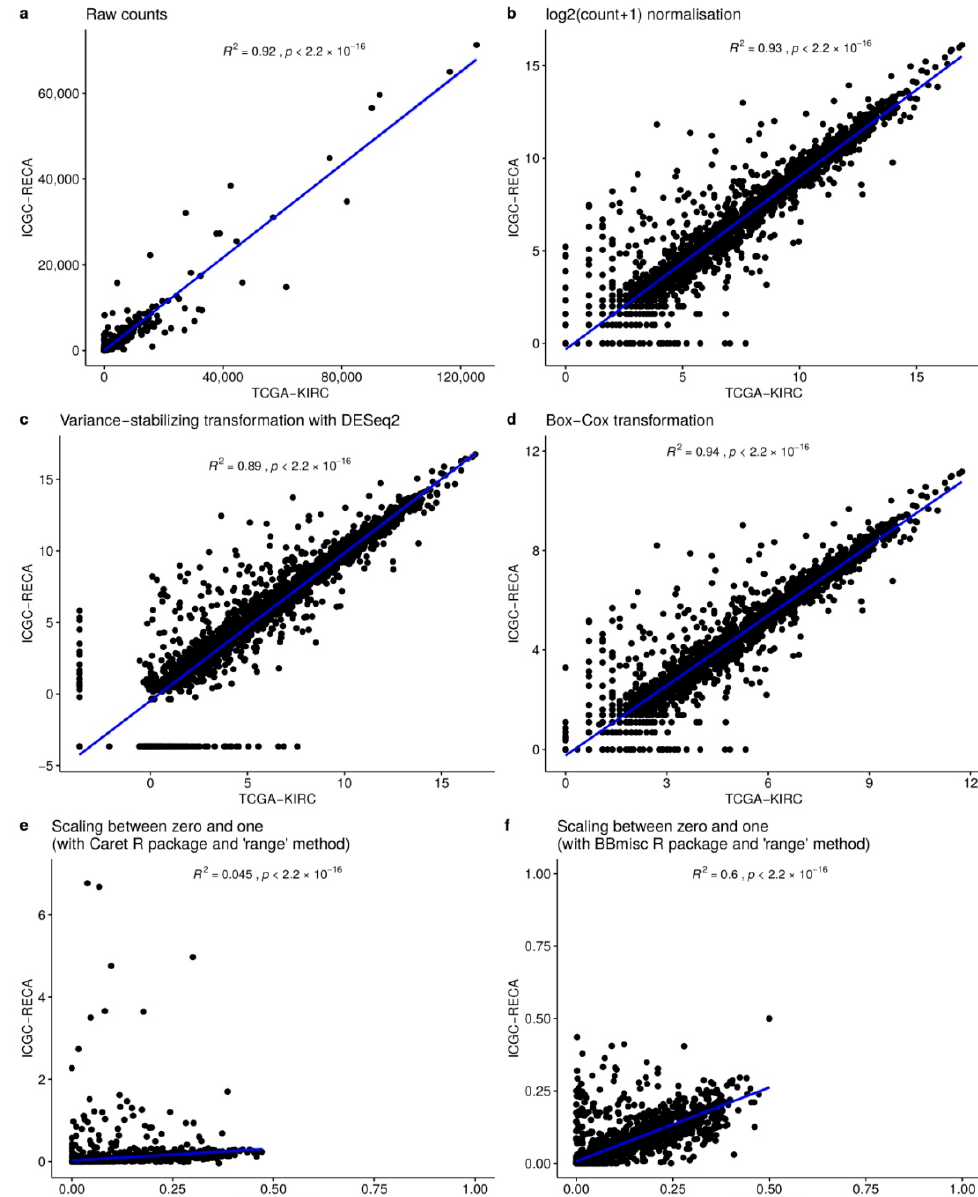
Figure A2. Scatter plot of median of gene expression comparing TCGA-KIRC and ICGC-RECA gene expression. ( a ) Raw counts. ( b ) log2(count + 1) normalization. ( c ) Variance-stabilizing transformation with DESeq2. ( d ) Box-Cox transformation. ( e ) Scaling between zero and one (with Caret R package and ‘range’ method). ( f ) Scaling between zero and one (with BBmisc R package and ‘range’ method).